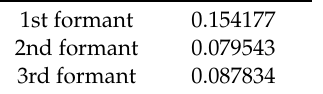
Table 6. The results of the correlation analysis for formant frequency (FF) and the ssAHI. (FF, formant frequencies; ssAHI, snore-specific